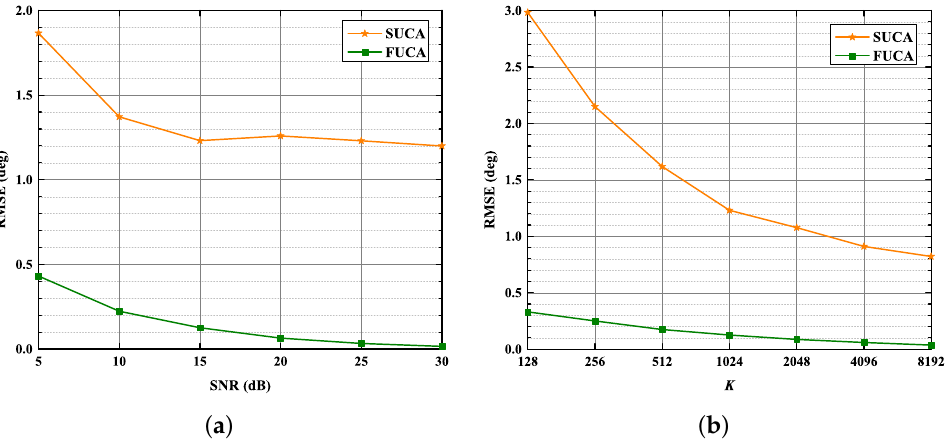
Figure 12. RMSE versus SNR, K : D = 4. ( a ) RMSE versus SNR, K = 1024; ( b ) RMSE versus K , SNR = 15